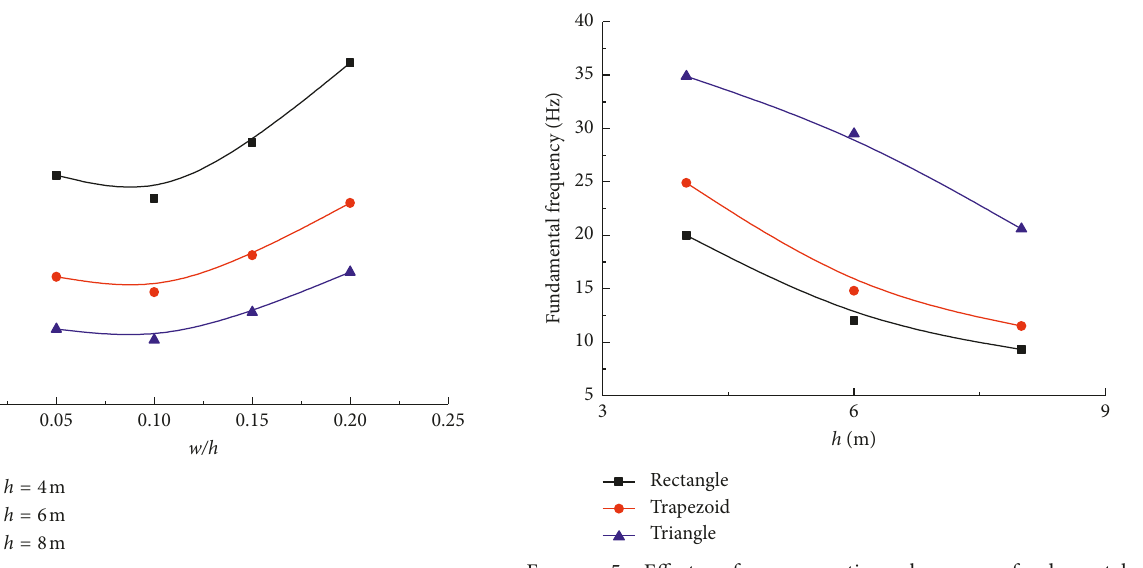
Figure 4: Effects of wall width on fundamental frequencies for walls with rectangular facings.